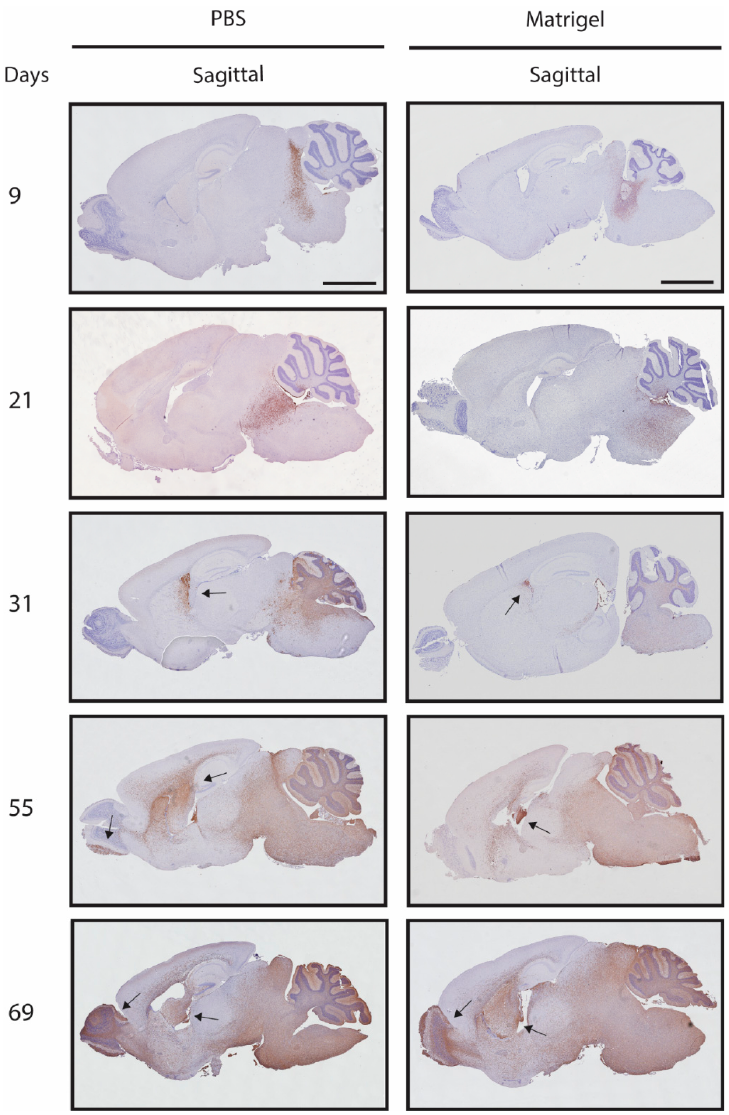
Figure 4. Antihuman vimentin staining of mouse brains showing tumour progression over time following inoculation with HSJD-DIPG-007 cells suspended in PBS or Matrigel. Tumour progression over time can be seen in both PBS and Matrigel groups through the accumulation and spread of human vimentin-positive cells (brown staining) within the pons and other, more distant brain regions. Metastases can be observed from day 31 in both PBS and Matrigel suspension groups (black arrows). Whole brain invasion of tumour cells can be observed at day 55 in both groups. Mouse brains in both groups were counterstained with haematoxylin. n = 9 for PBS group and n = 10 for Matrigel group. Scale bar = 2 mm.